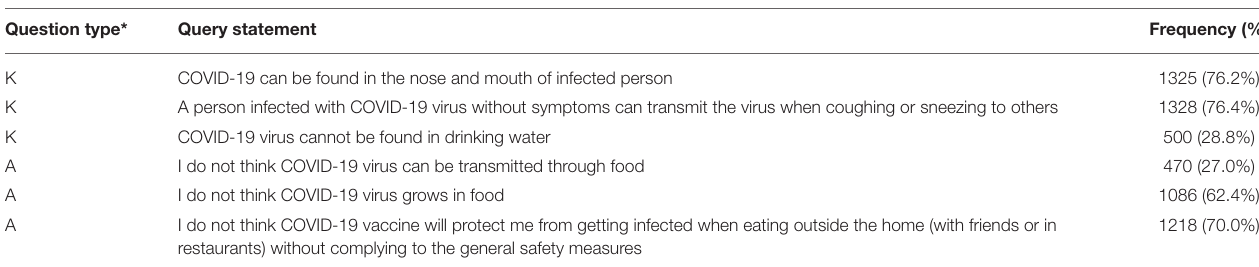
TABLE 2 | Query statements and responses of “COVID-19 food-related attributes”